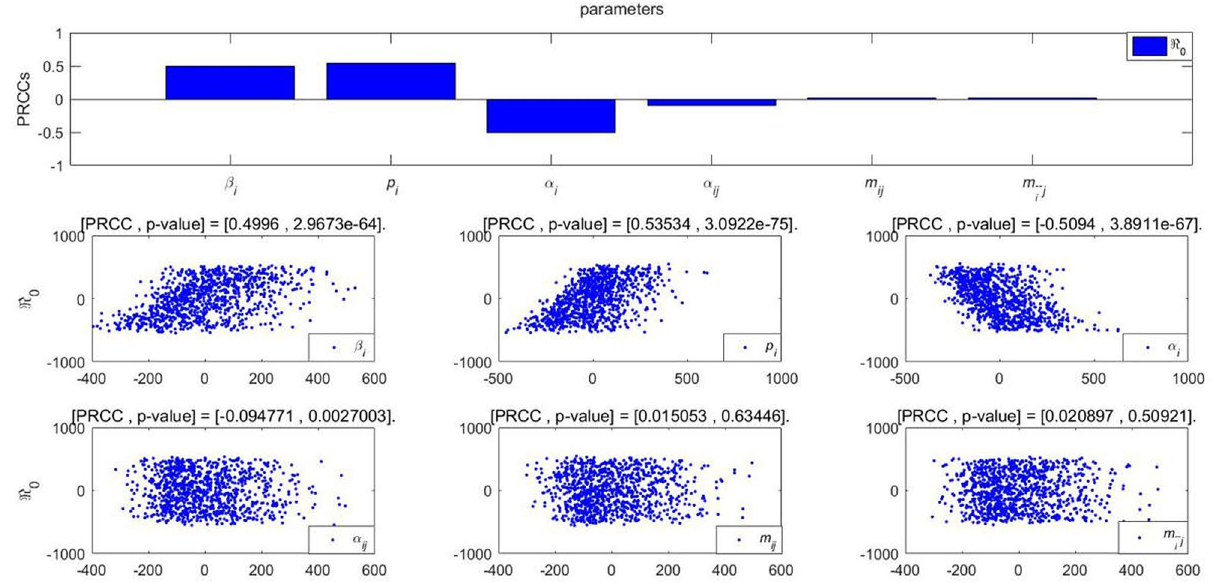
Figure 15. PRCC results and PRCC scatter plots with index R 0 of different parameters.